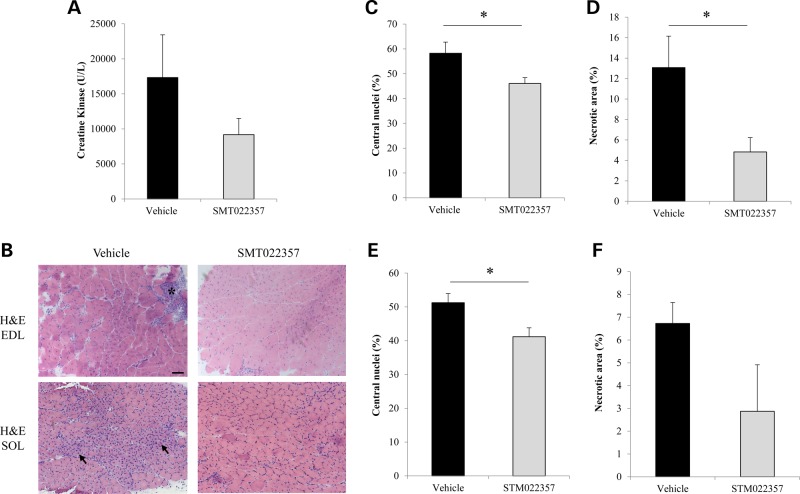
SMT022357 prevents muscular dystrophy in skeletal muscle. (A) Creatine kinase (CK) levels in serum following daily oral gavage of mdx mice with 30 mg/kg of SMT022357 or vehicle from two weeks of age for five weeks. A 47% decrease in serum CK was observed after treatment with SMT022357 compared to vehicle-treated animals (n = 7-9 per group). (B) H&E-stained transverse muscle sections of EDL muscle (7 weeks of age) in untreated vs. treated mdx mice (n = 10 per group) showing necrotic areas (black stars) and regenerating fibres (black arrows). Scale bar: 100 µm. (C) Muscle from mice dosed with SMT022357 showed a significant 20.1% (P = 0.03) decrease in centrally nucleated fibres compared to the vehicle group in EDL muscles. Values are mean ± SEM of n = 9 per groups; *P < 0.05. (D) The necrotic muscle area in EDL of mice treated with SMT022357 significantly decreased by 63.1% (P = 0.02) compared to the vehicle group. Values are mean ± SEM of n = 9 per groups; *P < 0.05. (E) Muscle from mice dosed with SMT022357 showed a significant 19.6% (P = 0.02) decrease in centrally nucleated fibres compared to the vehicle group in SOL muscles. Values are mean ± SEM of n = 7 per groups; *P < 0.05. (F) The necrotic muscle area in SOL of mice treated with SMT022357 decreased by 57.3% (P = 0.06) compared to the vehicle group. Values are mean ± SEM of n = 7 per groups.